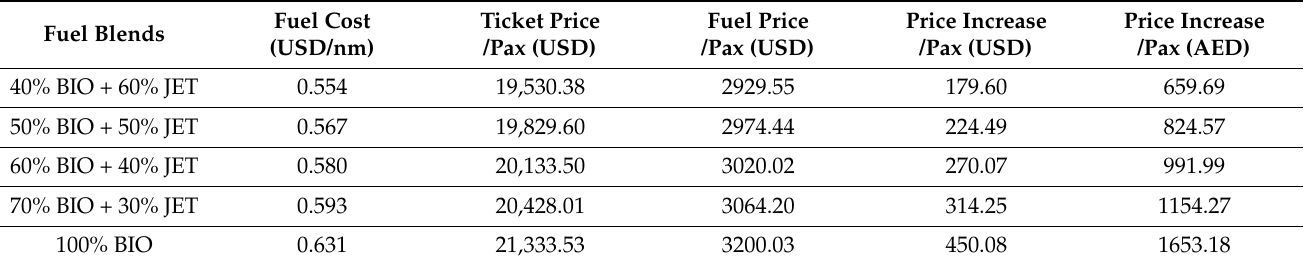
Table 9. Effects of the biofuel price on the fuel expenses for the business jet operating cost and ticket price for the